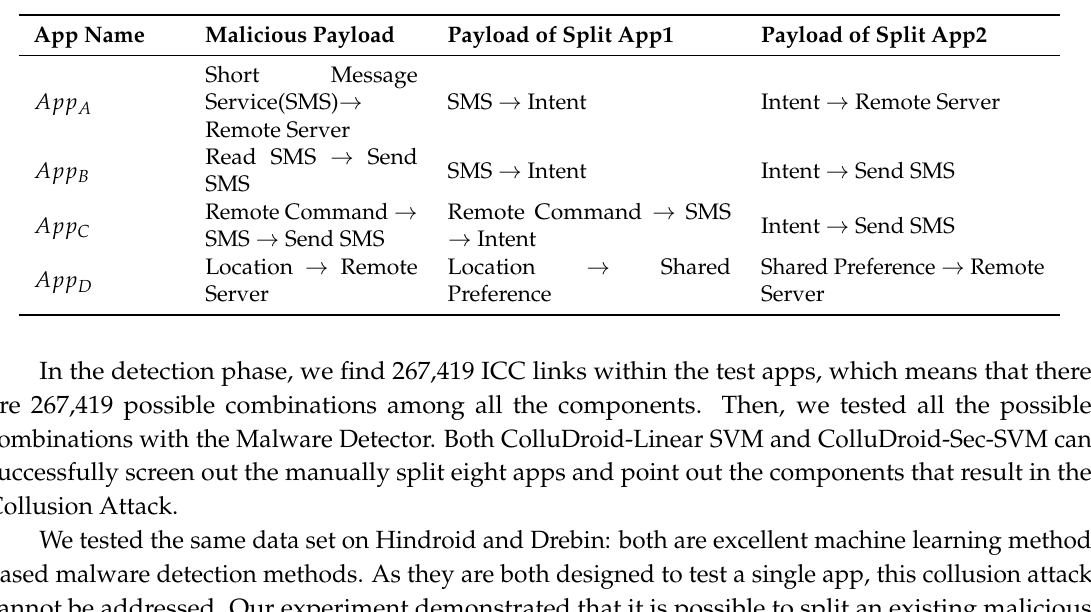
Table 1. Manually made apps in our